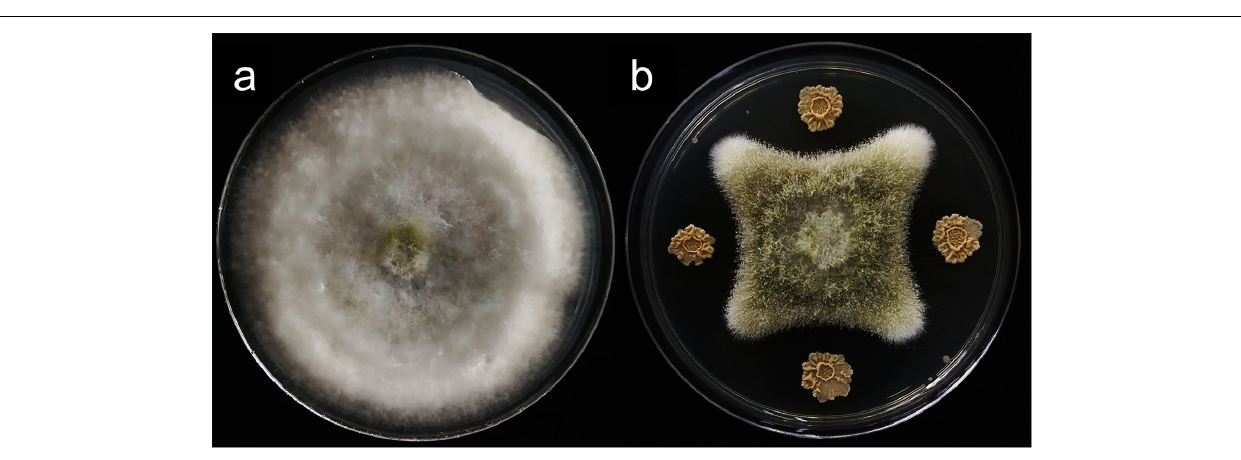
FIGURE 2 | The inhibitory effect of strain m29 on the growth of Aspergillus flavus ( A. flavus ). (A) A. flavus grown for 7 days; (B) A. flavus was located in the middle of the PDA plate, and m29 was located 3 cm apart away from the